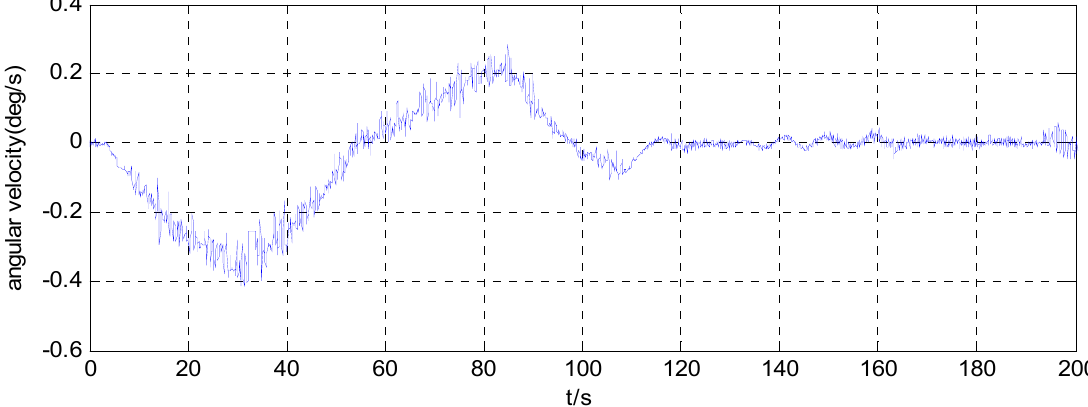
Figure 6. Angle around the z-axis of the simulator when